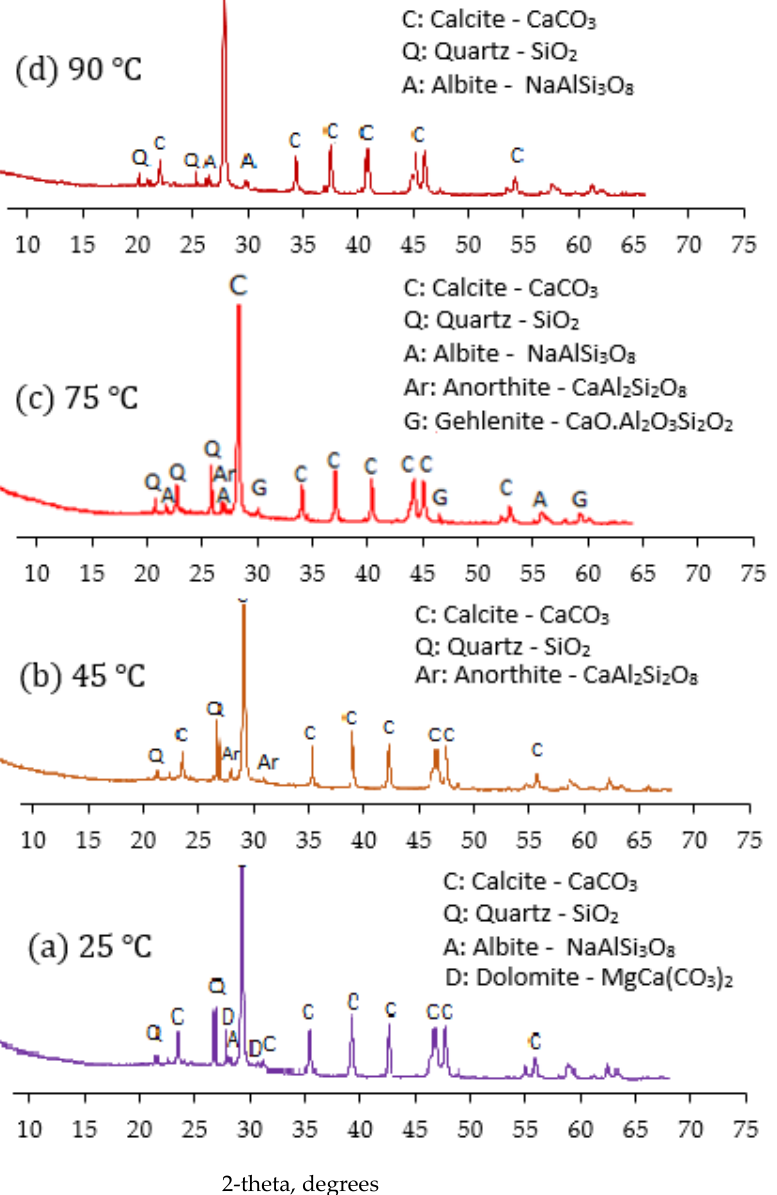
Figure 12. XRD of the activated product at different curing temperatures: ( a ) 25 °C; ( b ) 45 °C; ( c ) 75 °C; ( d ) 90 °C.